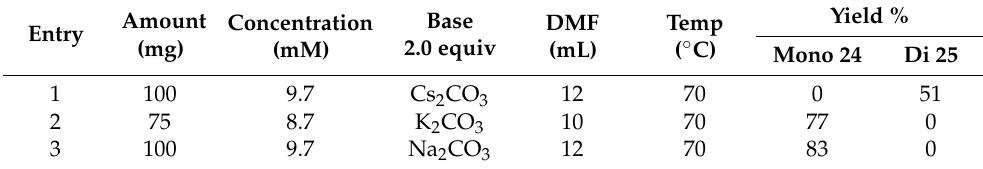
Table 1. Macrolactonization of the intermediate 23 using different bases.